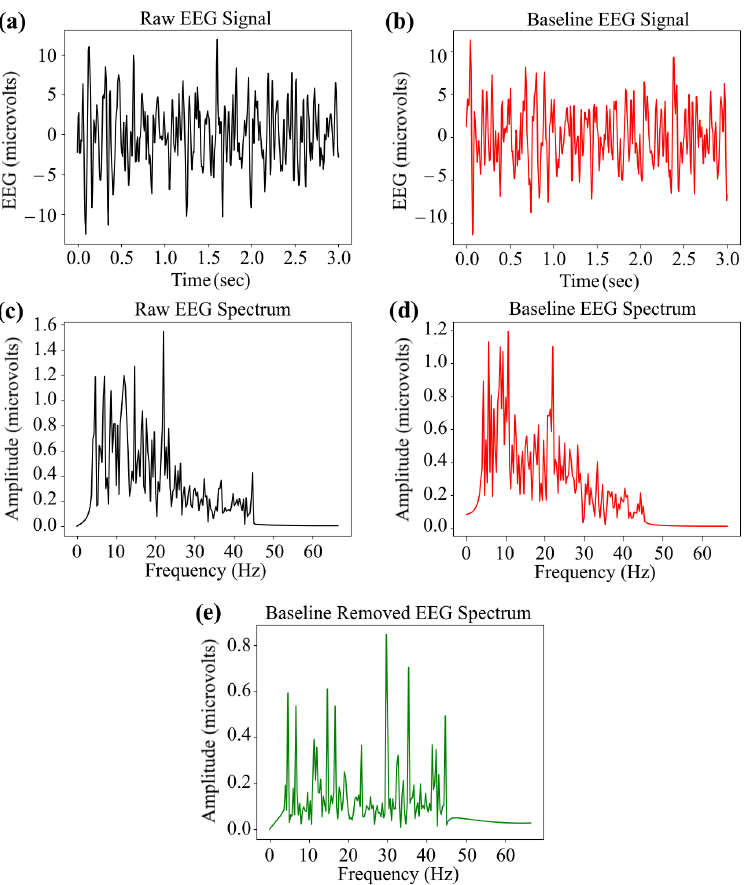
Figure 2. An example of baseline EEG removal results: ( a ) raw EEG signal in a 3 s time slot, ( b ) baseline EEG signal captured for 3 s, ( c ) frequency spectrum of the raw EEG signal, ( d ) frequency spectrum of the baseline EEG signal, and ( e ) the baseline removal in a 3 s time slot from a channel using the InvBase